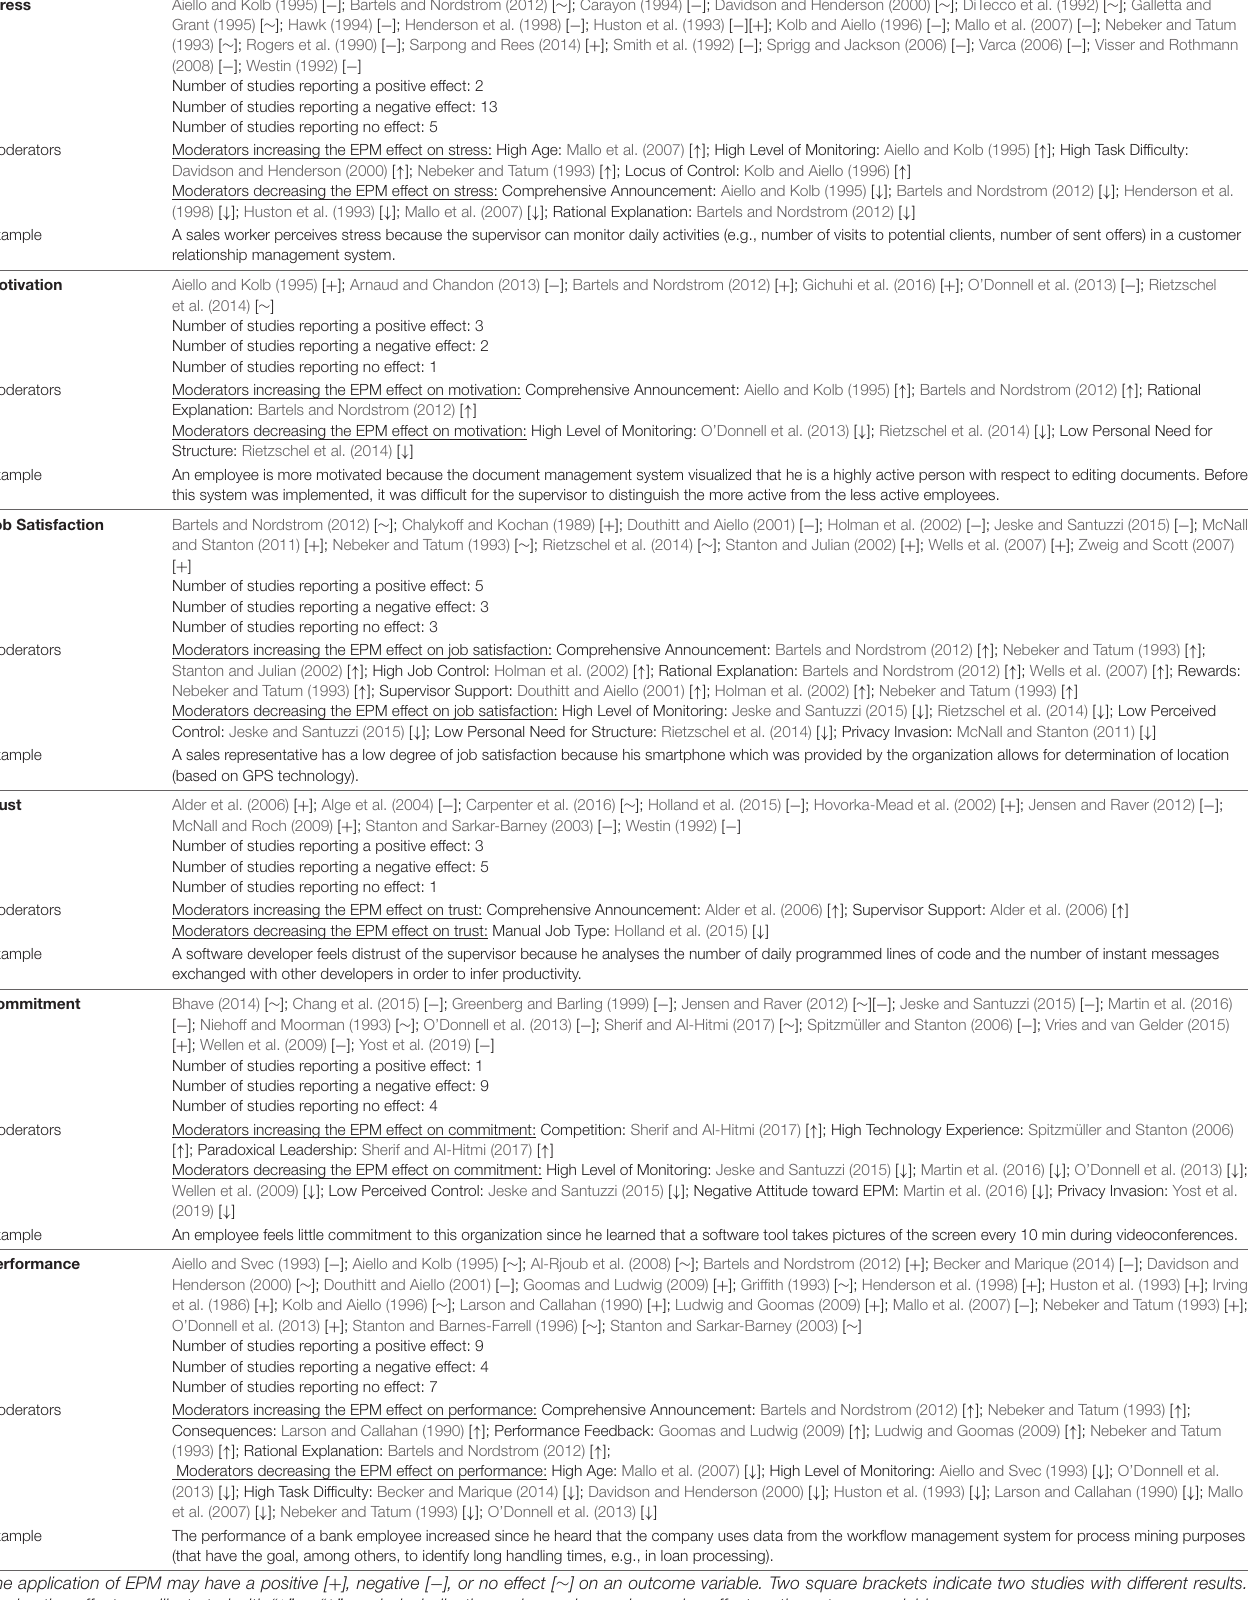
TABLE 1 | Research findings on EPM use and outcome variables along with moderator effects.